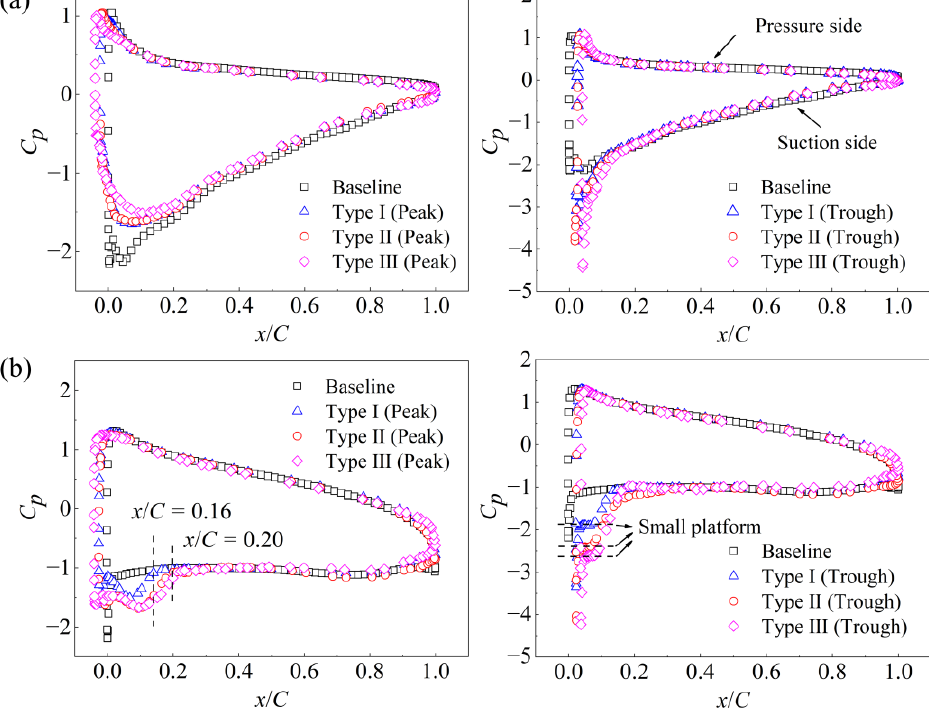
Figure 6. Pressure distribution comparison of the modified hydrofoils’ peak and trough sections with the baseline hydrofoil’s mid-spans for AOA = 8° ( a ), and AOA = 25° ( b ).